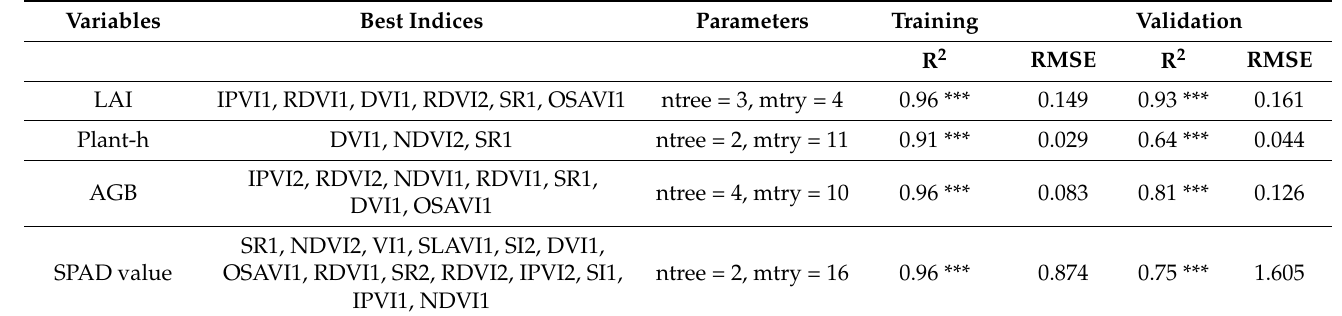
Table 11. Outcomes of calibration ( n = 96) and validation models ( n = 48) of random forest for the association between the best V-SRIs extracted from in situ spectrometry and satellite imagery and leaf area index, plant height, above ground biomass and SPAD